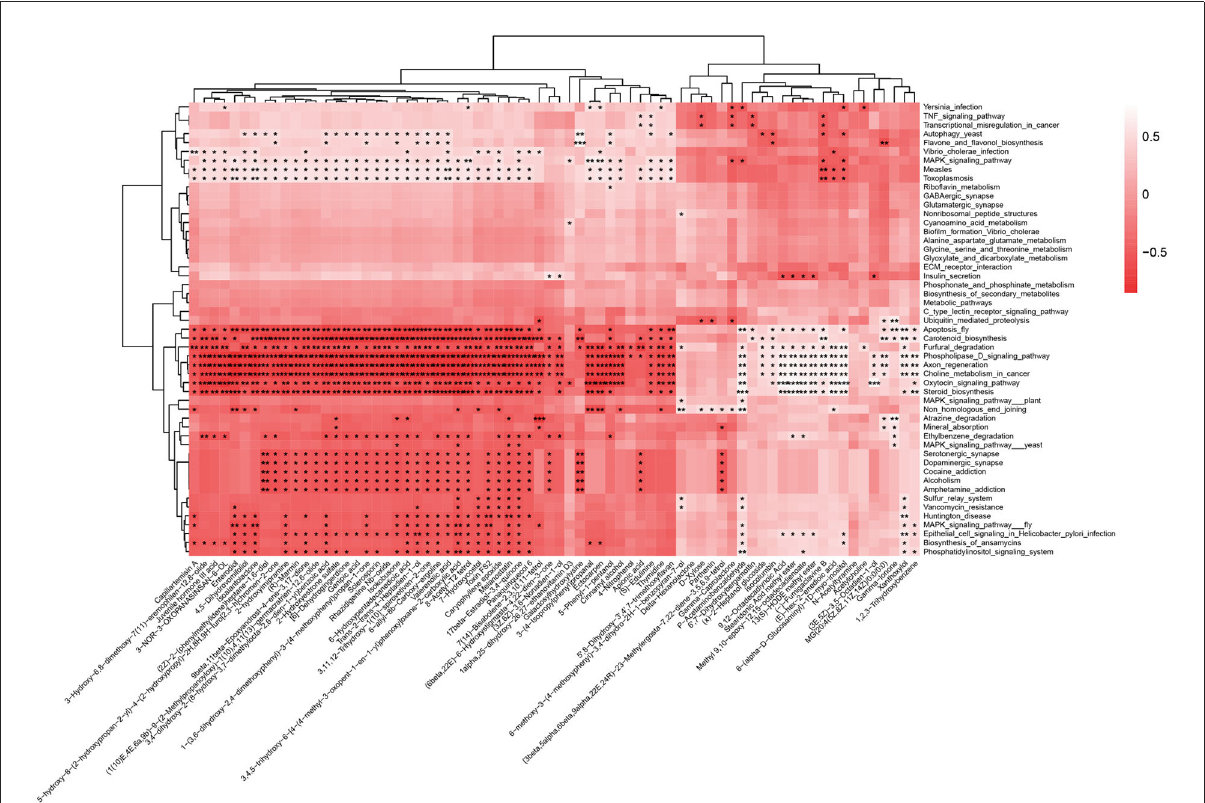
FIGURE7 Many differential metabolites are negatively correlated with metabolic pathways. The horizontal axis represents 73 differential metabolites among three groups ( P < 0.01) from fecal LC-MS data, and the vertical axis represents differential metabolic pathways ( P < 0.01) among the three groups from fecal metagenomics data. The darker the color of the block, the greater the negative correlation. * P < 0.05, ** P < 0.01, *** P <